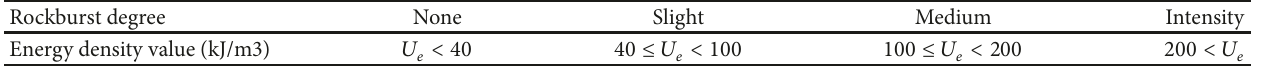
Table 3: Grading value of rockburst tendentiousness [37].